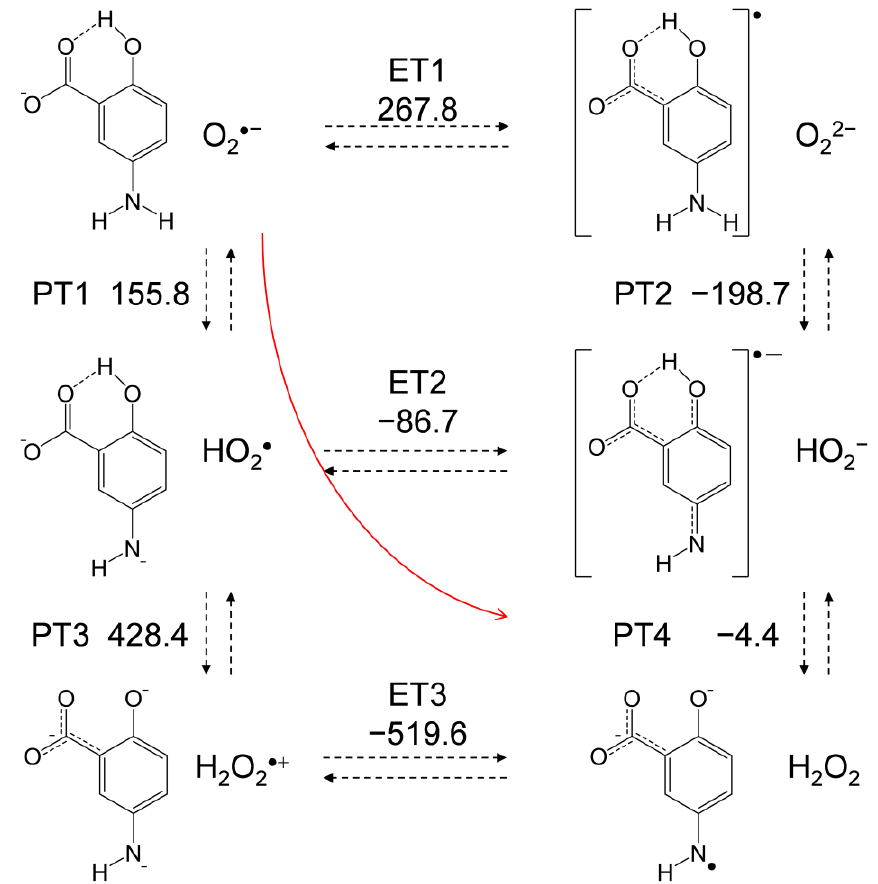
Figure 7. Six diabatic electronic states and the Δ G ° values for the PCET between O 2•− and the deprotonated 5-ASA anion involving two PTs and one ET. Δ G ° (kJ mol −1 , 298.15 K) for the PT (PT1 – PT4) and ET (ET1 – ET3) were calculated using the DFT-(U)B3LYP/PCM/6-311+G(d,p) method.